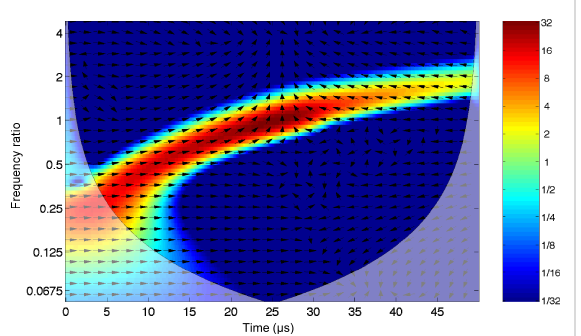
Figure 2: Wavelet cross-correlation between the chirped driver and the response of the damped harmonic oscillator (quality factor Q = 4), as shown in Figure 1. The wavelet cross-correlation coefficients (reported in the color scale) evidence the common power between the two time series in the time–frequency plane. Note that the frequency axis is represented in octaves as the base-2 logarithm of the ratio of the oscillator frequency to the resonant frequency. The color scale is proportional to the wavelet cross-correlation power and is represented in octaves. The arrows superimposed on the representation given by the color scale show the local phase difference between the oscillator and the driver. Arrow pointing right: in-phase; left: anti-phase; up: oscil- lator lagging behind driver by 90°. The area where edge artifacts may distort the picture are delimited by a lighter shade.